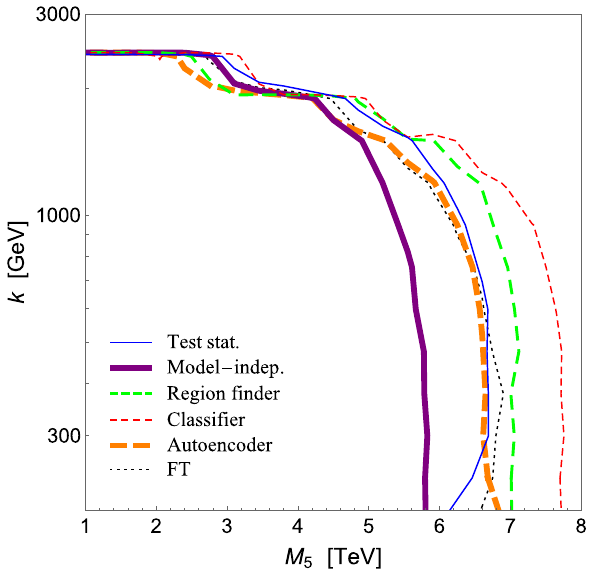
Fig. 7 Comparison between the 2 σ sensitivity of the various search methods, in the parameter space of the CW/LD model, based on the γγ dataset of Ref. [10] (see Appendix A for details). Thin lines corre- spondtomethodsdesignedforaspecificmodelandspecificparameters, mediumlinestomethodsdesignedforaspecificmodelbutnotaspecific point and thick lines to searches for a general signal. Solid lines do not use machine learning and dashed ones do. The regions covered by